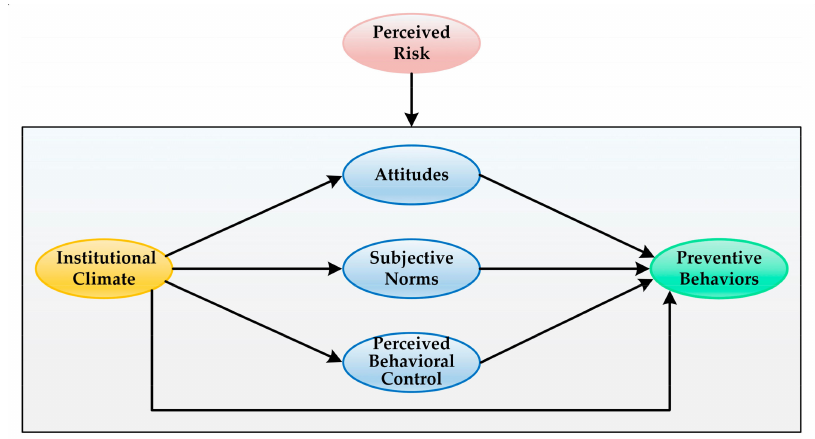
Figure 1. Research